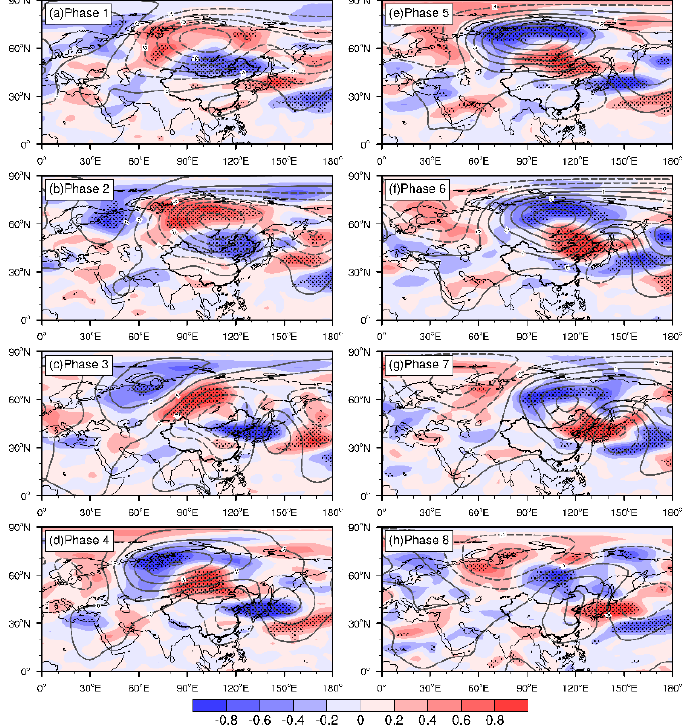
Figure 5. Phase evolution of 10–30 d filtered 500 hPa vorticity (shading; unit: 10 5 s − 1 ) and SLP (contour; unit: hPa) of LECEs (( a – h ), dotted area passes the 95% significance level).